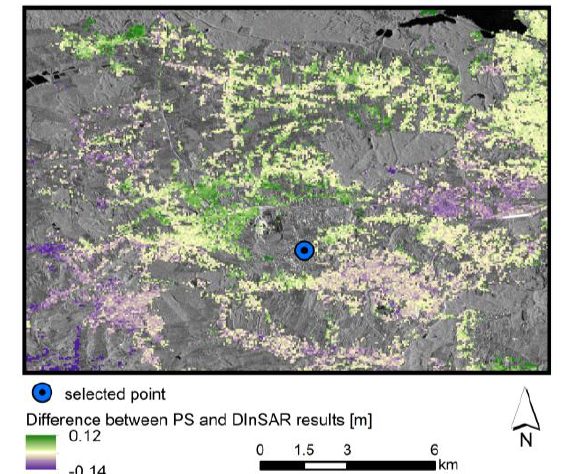
Figure 6. Time series extracted from PSI and DInSAR results for a selected point (Fig 6)